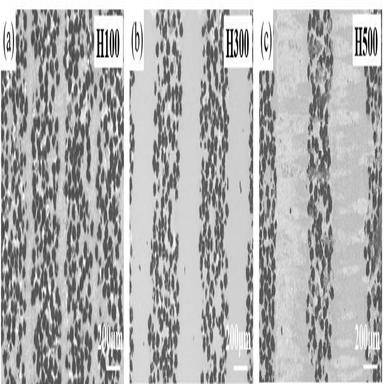
Morphology of multilayer composites with different thickness of Si3N4 layer: (a)100 lm, (b) 300 lm, and (c) 500 lm.